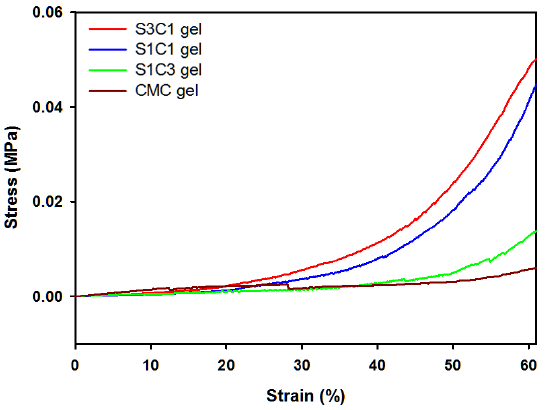
Figure 4. Compressive stress–strain curves of hydrogels with different SG concentrations.